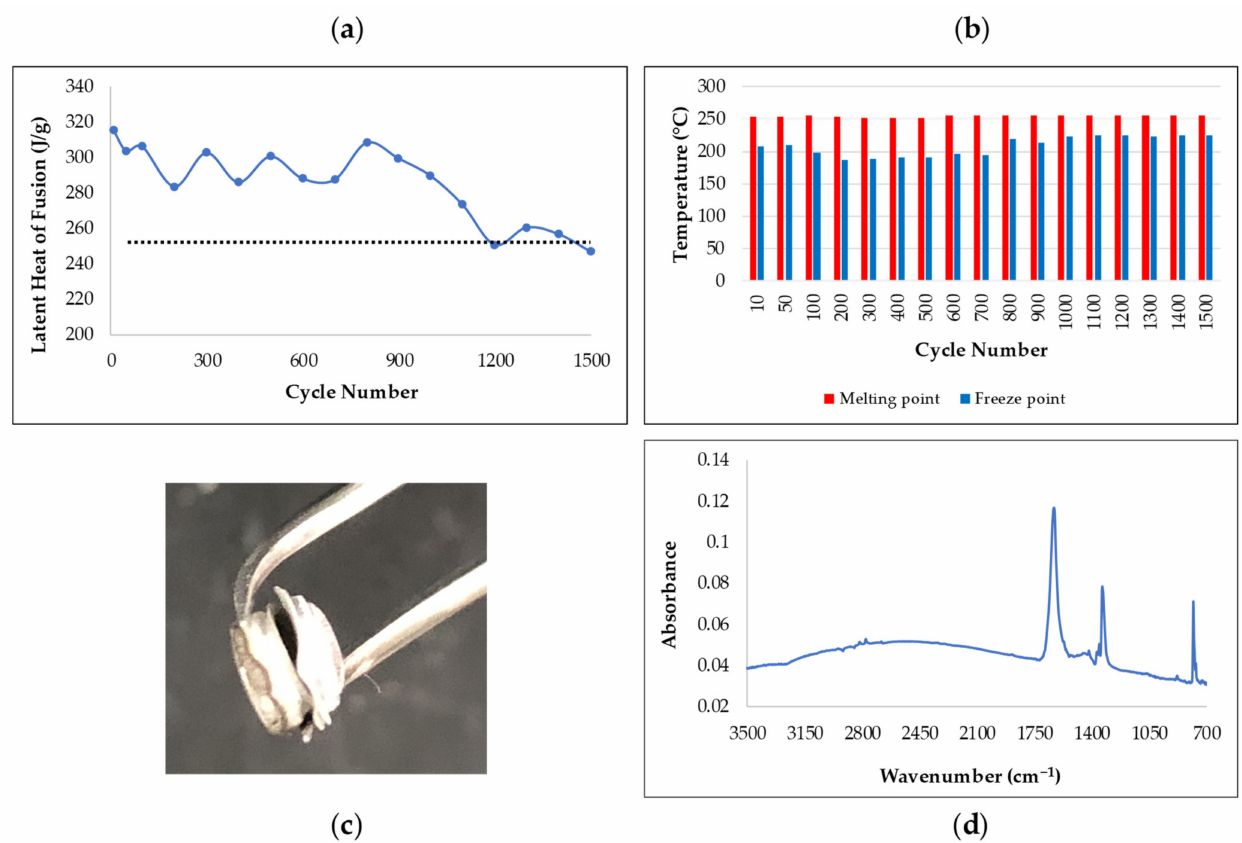
Figure 2. ( a ) Latent heat of sodium formate as a function of thermal cycles, ( b ) plot of melting and freezing points of sodium formation as a function of thermal cycles, ( c ) Image of ruptured differential scanning calorimetry (DSC) pan, and ( d ) FTIR spectrum of cycled sodium formate phase change material (PCM), showing degradation to sodium